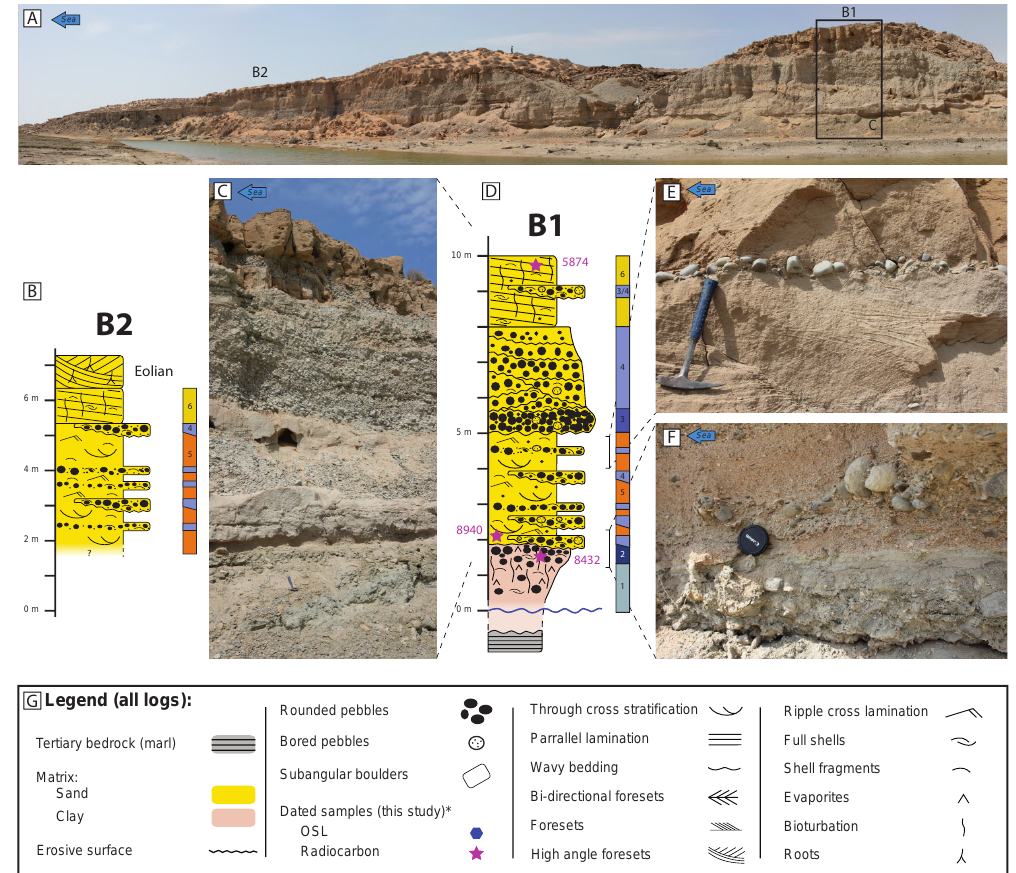
Figure 5. Beris Beach stratigraphic logs. Facies numbering is as reported in Table 3. ( A ) Beris Beach transect. N 25.219, E 60.985. ( B ) Log B2. ( C ) Close up of the transect at the position of log B1 (black square in Figure 5A). ( D ) Log B1. ( E ) Close up of facies 5. ( F ) Close up of the bottom of log B1, the transition from facies 2 to 4-5. ( G ) Legend for all logs (Figure 5 and Figure 7). *Ages’ standard